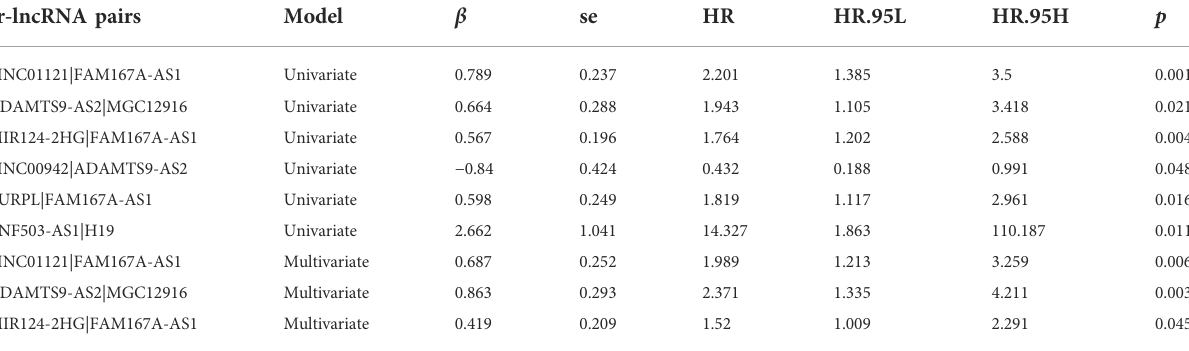
TABLE 3 Univariate and multivariate COX regression analysis of differential ir-lncRNAs. Ir-lncRNA pairs